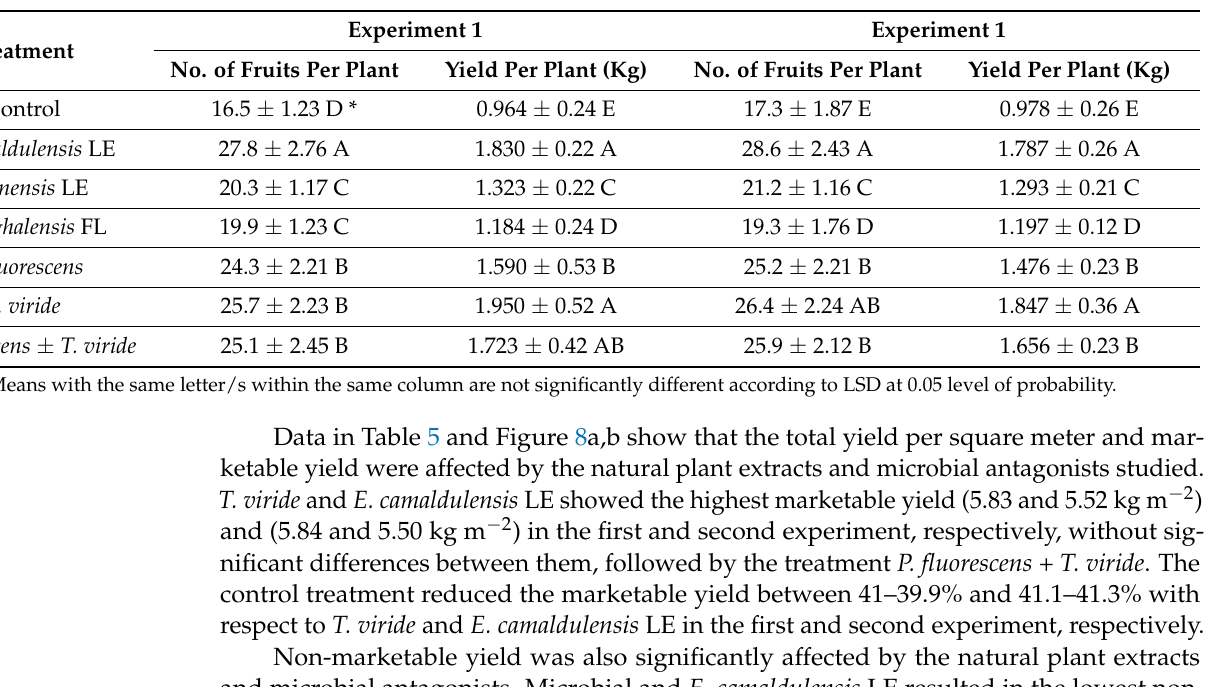
Table 4. Number of fruit per plant and total yield per plant (kg) of zucchini as affected by natural plant extracts and microbial antagonists.